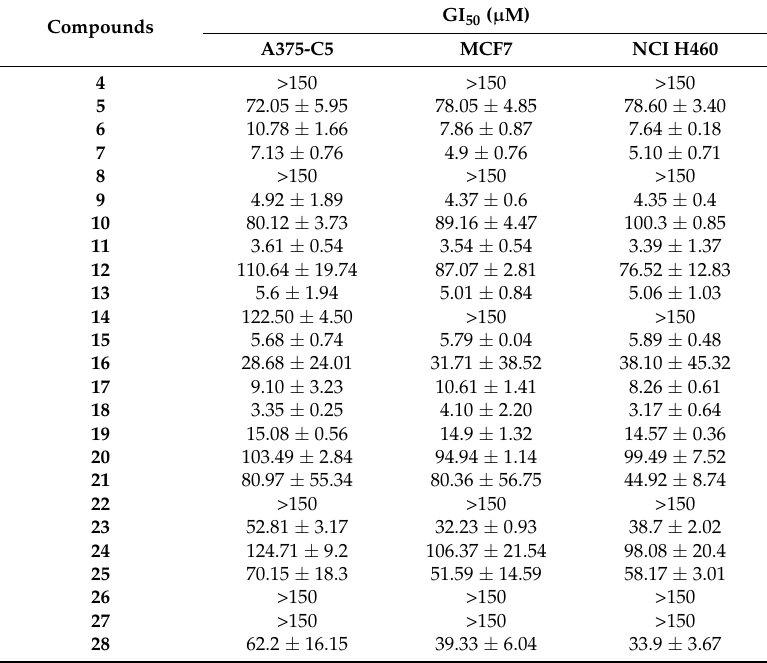
Table 1. Effect of flavonoids 4 – 28 on the growth of human tumor cell